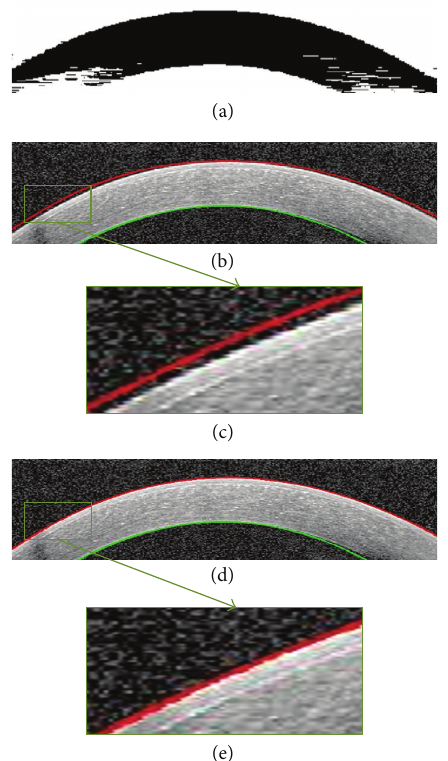
Figure 6: Segmentation of Epithelium and Endothelium bound- aries. (a) GMM output. This is the image used for segmentation of desirable boundaries. (b) Segmentation result before correction. (c) Zoomed results of extracted Epithelium before correction. (d) Epithelium boundary after correction. (e) Zoomed results of extracted Epithelium after